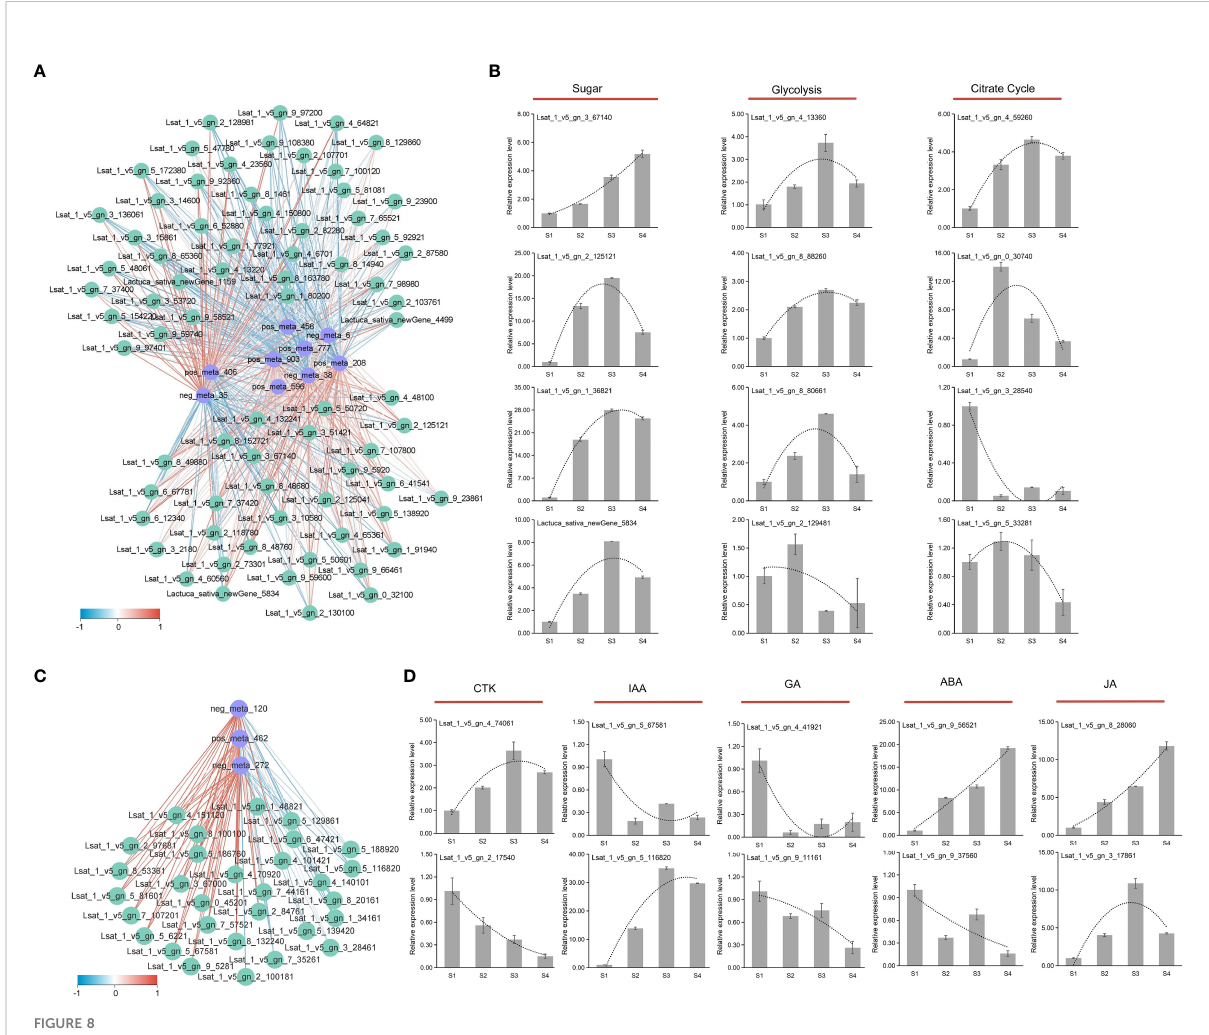
FIGURE 8 Correlation network analysis and gene veri fi cation of sugar, acid, and hormone metabolism. (A) Correlation network analysis diagram of DEMs (blue) and DEGs (green) related to glucose synthesis metabolism. The correlation was represented by blue and red lines from low to high. (B) qRT-PCR analysis of genes involved in sugar and acid biosynthesis. (C) The correlation network analysis diagram of DEMs (blue) and DEGs (green) related to auxin synthesis metabolism. The correlation was represented by blue and red lines from low to high. (D) qRT-PCR analysis of genes involved in hormone